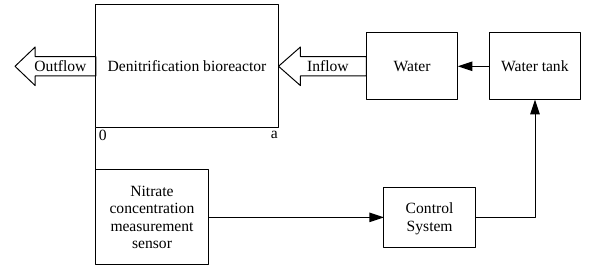
Figure 2. Principal scheme of the denitrification process under PI